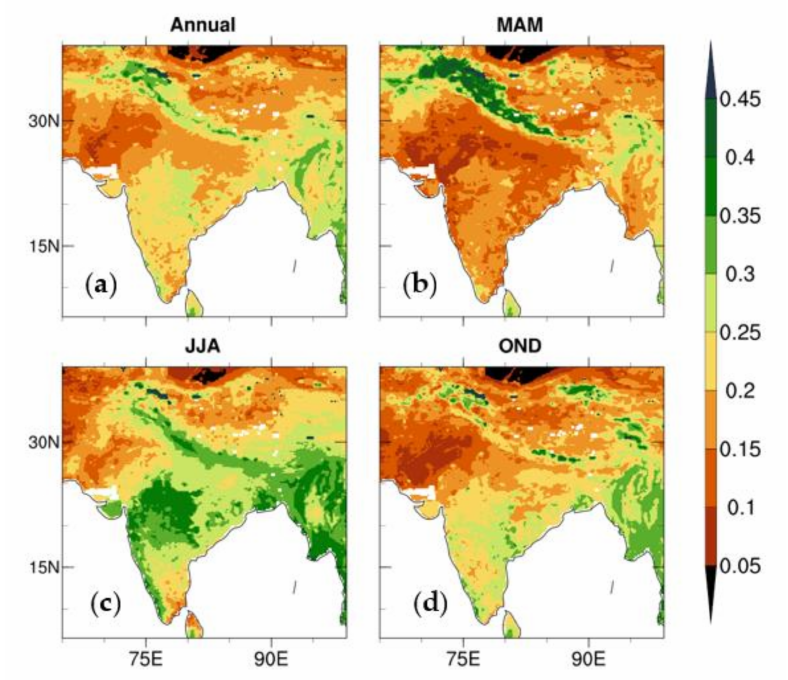
Figure 1. ( a ) Annual volumetric soil moisture (m 3 m − 3 ) content obtained from the control experiments during 2013; ( b – d ) are the same as ( a ) but for MAM, JJA, and OND,